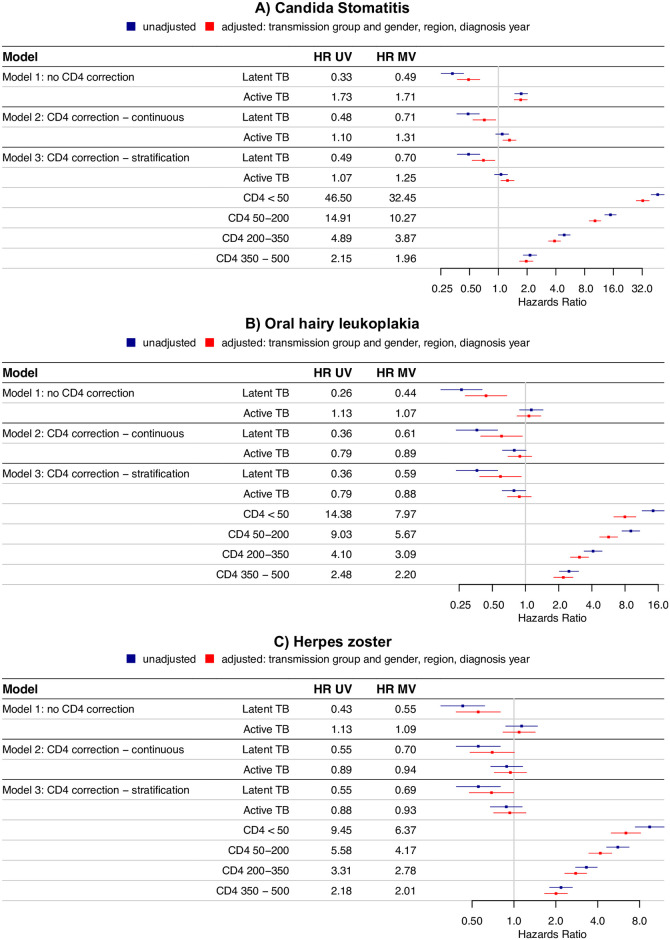
Time-to-event analysis of the occurrence of candida stomatitis (A), oral hairy leukoplakia (B), and herpes zoster (C): Patients with active TB or LTBI compared to MTB uninfected patients, respectively.The lines indicate the 95% CIs obtained through the cox proportional hazards model; the dots indicate the HRs. (see S3 Data for the underlying numerical values) CI, confidence interval; HR, hazards ratio; LTBI, latent tuberculosis infection; MTB, Mycobacterium tuberculosis; MV, multivariable; TB, tuberculosis; UV, univariable.